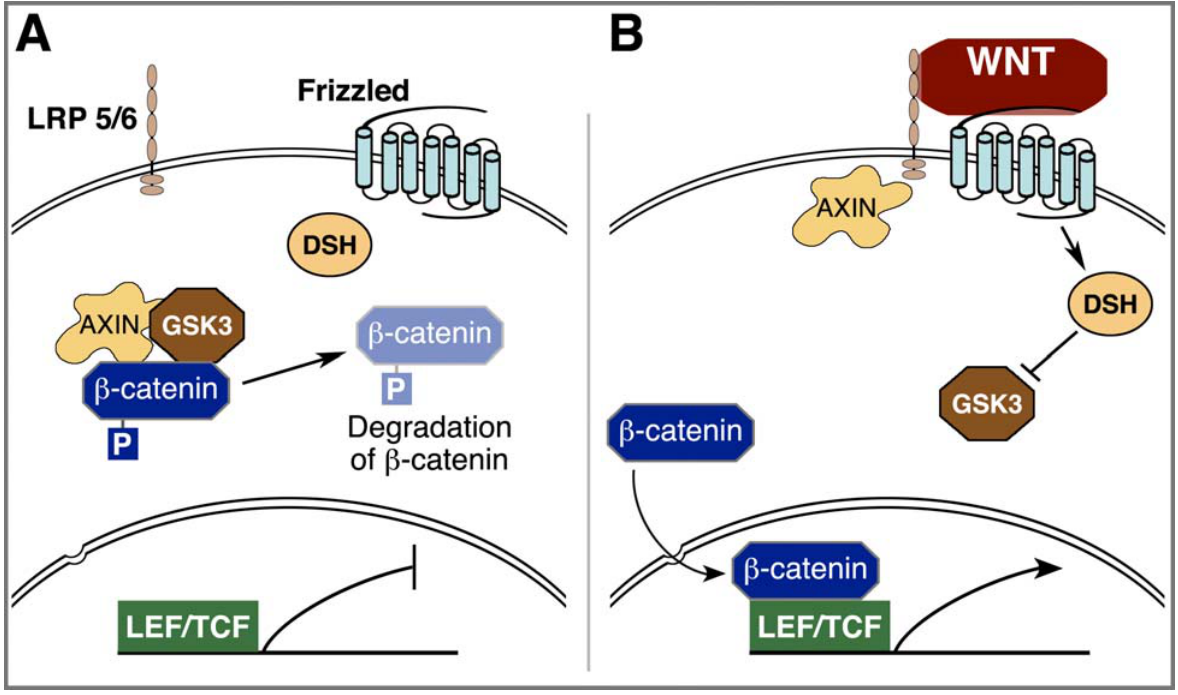
FIGURE 1 . The canonical Wnt signal transduction pathway. (A) In the absence of Wnt protein, β -catenin is sequestered within a multiprotein cluster that includes glycogen synthase kinase 3 (GSK3) and Axin. GSK3 phosphorylation of β -catenin targets the latter protein for degradation by ubiquination. (B) Wnt binding to frizzled and LRP5/6 transmembrane proteins transduces signal via the cytoplasmic protein Dishevelled (Dsh) and causes the inactivation of GSK3. This action preventing GSK3 tagging of β -catenin allows the latter protein to accumulate within the cytoplasm. Subsequently, β -catenin translocates to the nucleus and forms a transcriptional enhancer complex with LEF/TCF DNA binding proteins, which results in the up-regulation of Wnt target genes. More detailed information on canonical WNT signal transduction can be found at “The Wnt Homepage” at